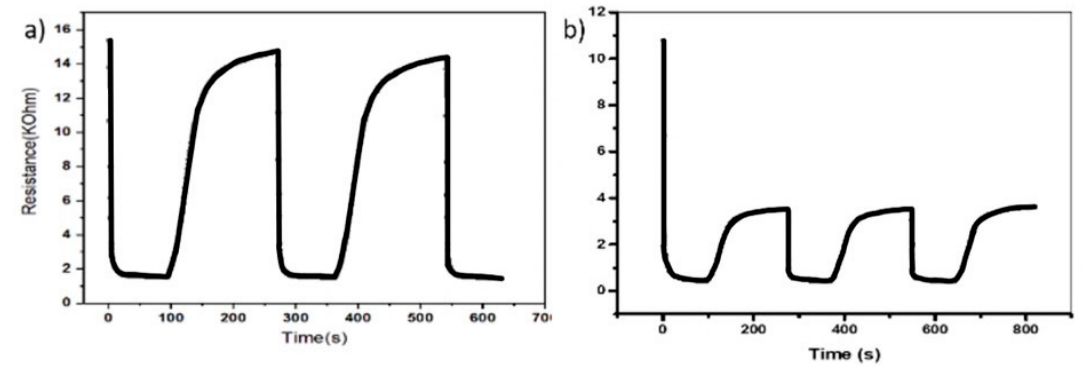
Figure 5. Result of sensor reliability test: ( a ) resistance of sensing element changes with an injection of 1 ppm of acetone, ( b ) resistance of the sensing element change with an injection of 10 ppm of acetone.